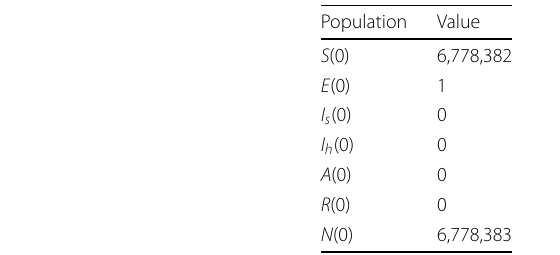
Table 2 Initial conditions for